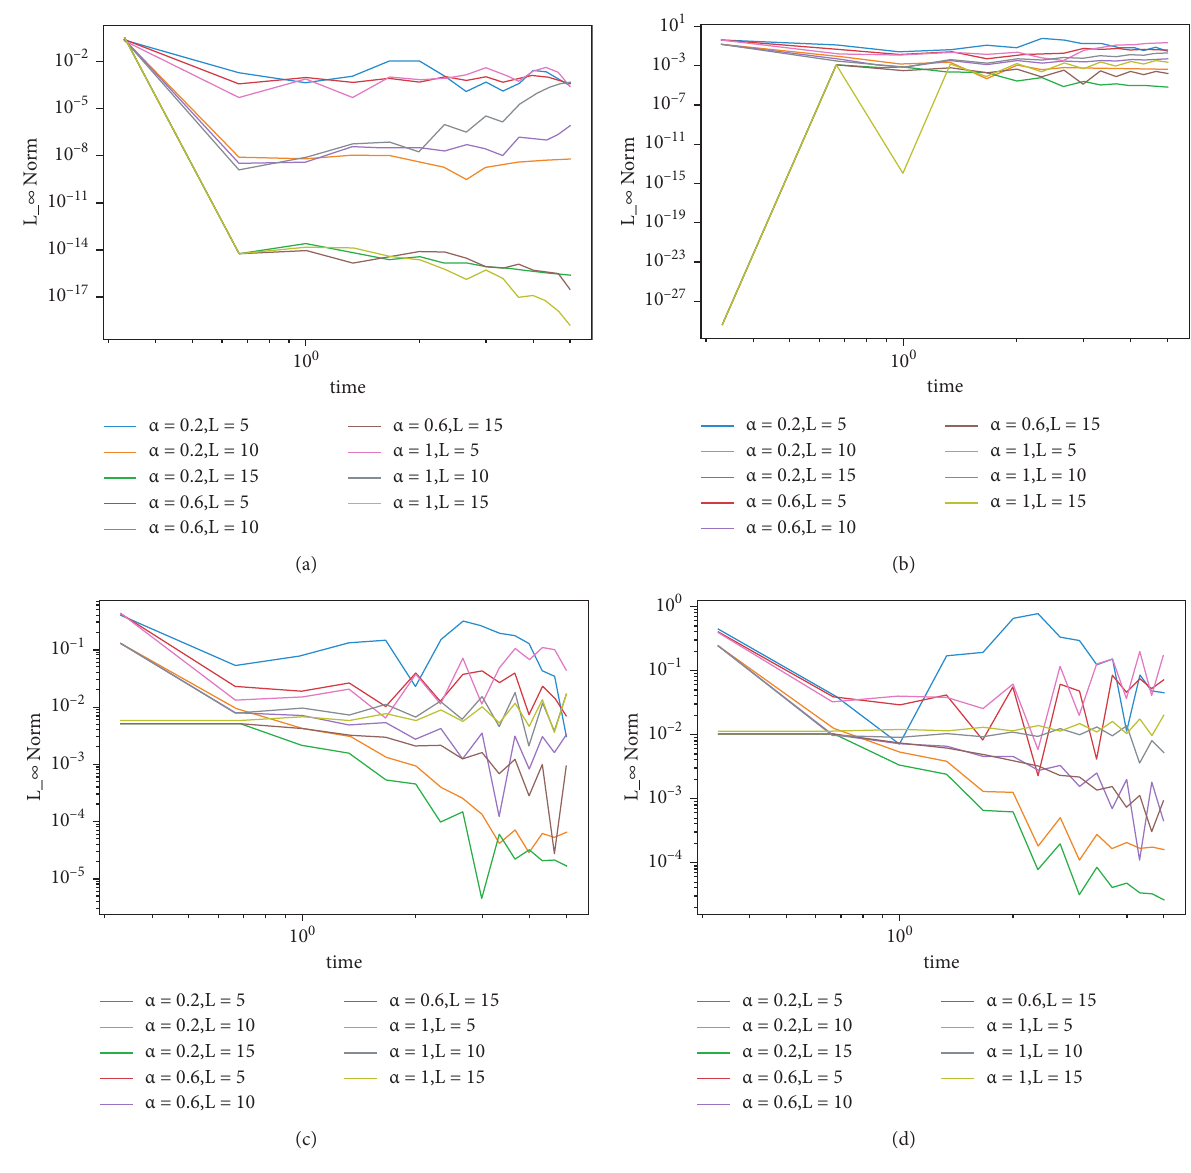
Figure 1: Convergence plots at x � y � p